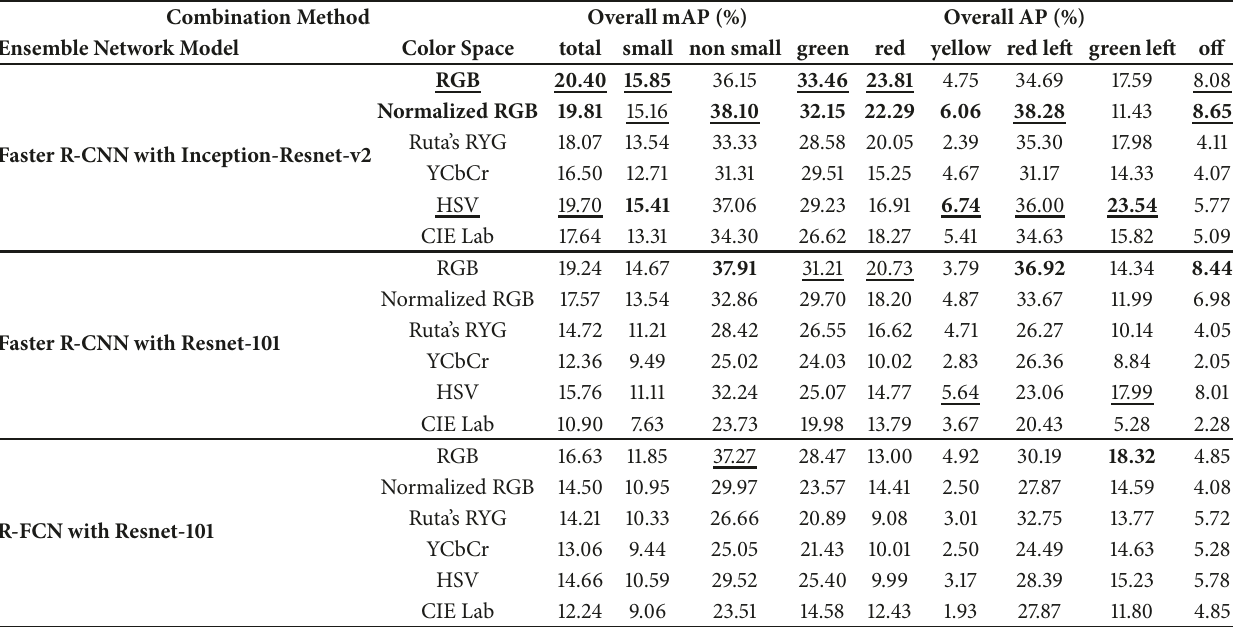
Table 4: Detection performances (overall mAP and overall AP) of combination methods on test